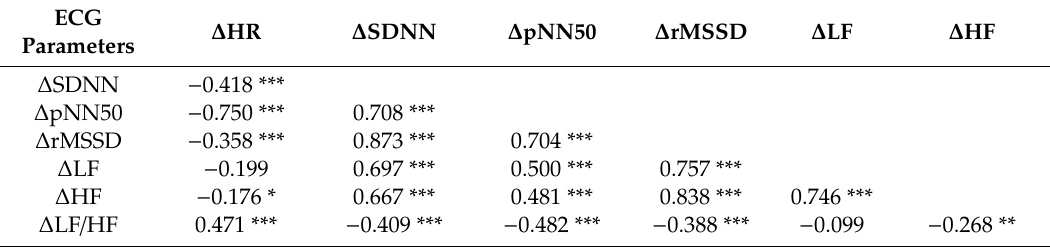
Table 4. Pearson correlation between the variations of the cardiovascular measurements. ECG Parameters